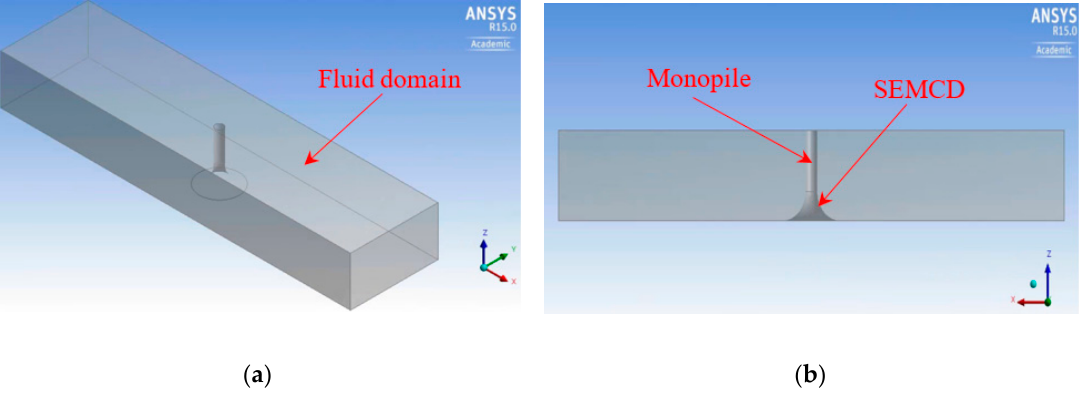
Figure 4. Fluid domain and the numerical models of the SEMCD and the monopile foundation: ( a ) isometric view; ( b ) rear view.